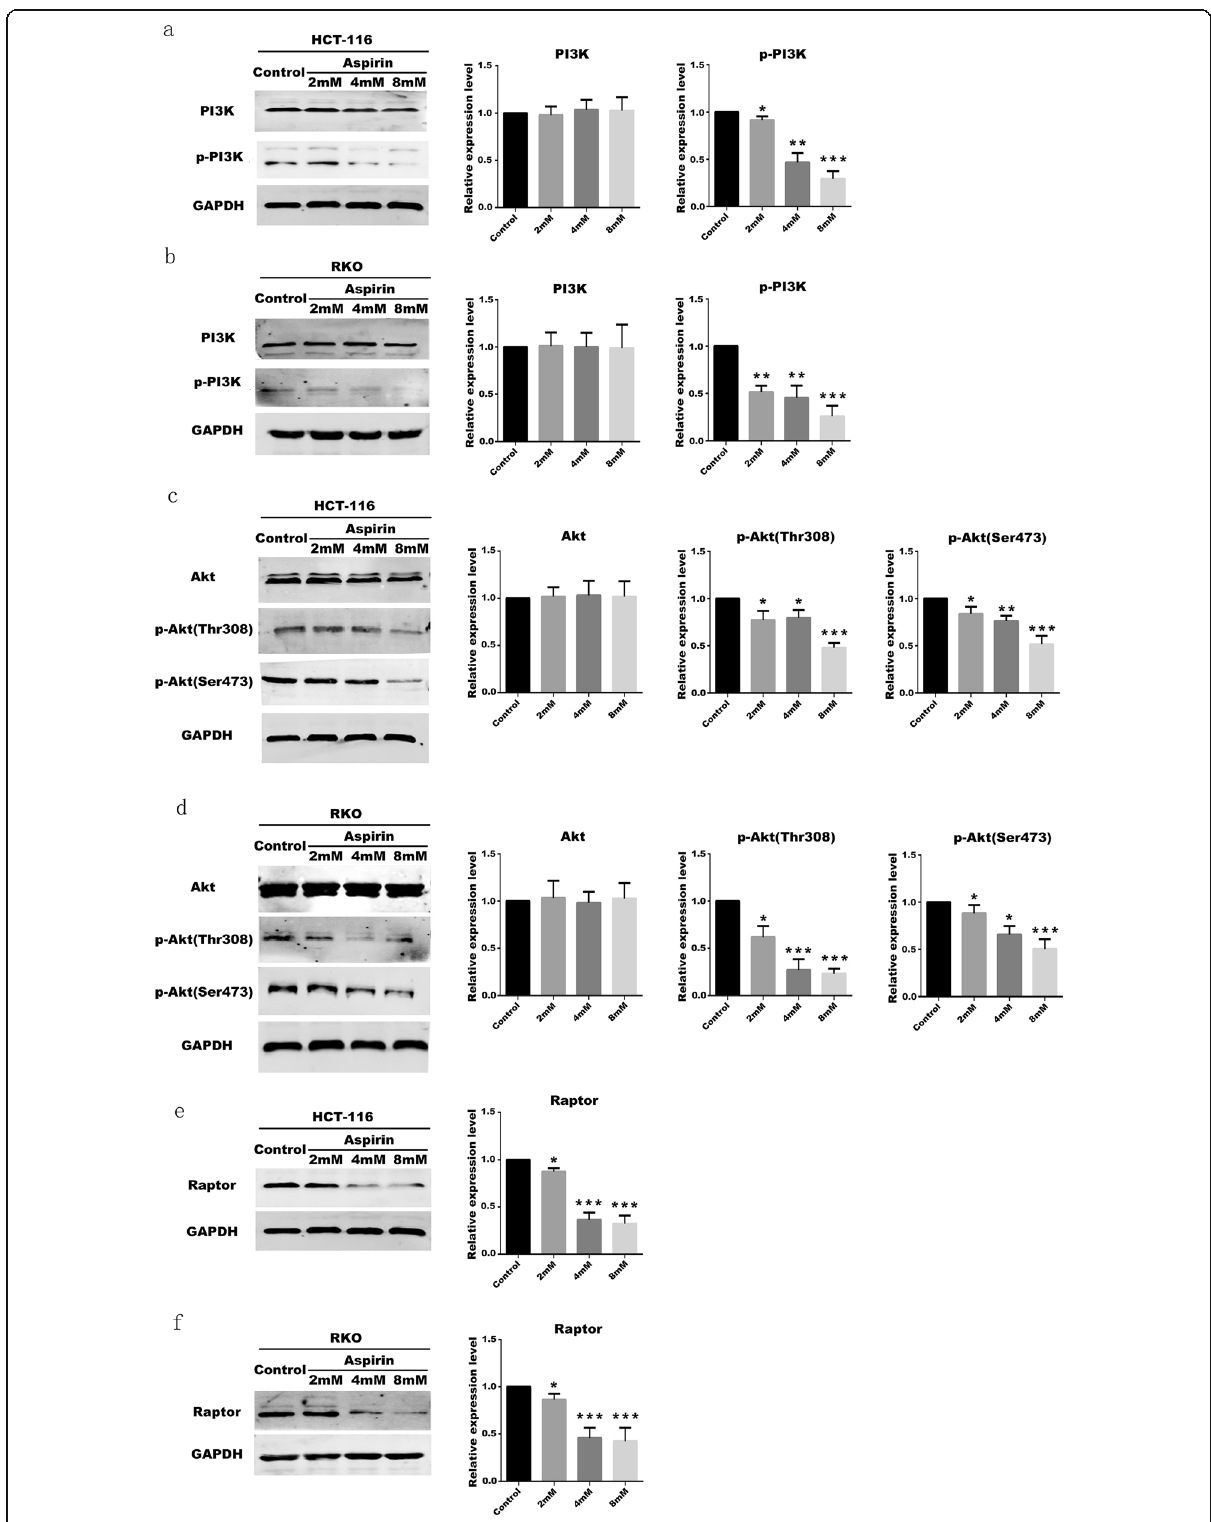
Fig. 2 (See legend on next